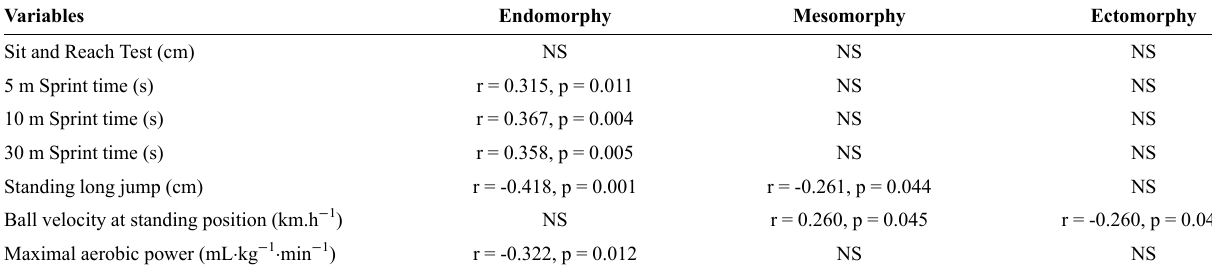
Table 3 - Pearson's correlation between somatotype components and general physical fitness tests and throwing velocity.